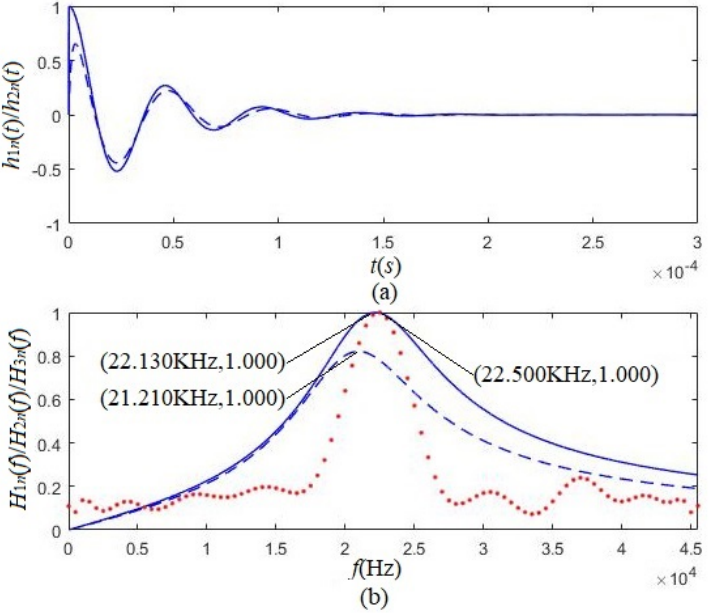
Figure 6. The normalized electric–acoustic impulse responses and corresponding amplitude spectra of the tangentially and radially polarized thin cylindrical piezoelectric transducers. The solid and dashed lines are for the tangentially and radially polarized thin cylindrical transducers, respectively. The dotted line is the experimentally measured amplitude spectrum of tangentially polarized thin cylindrical transducers. Where, h 1 n ( t ) = h 1 ( t ) / h 1max , h 2 n ( t ) = h 2 ( t ) / h 1max , H 1 n ( f ) = H 1 ( f ) / H 1max , H 2 n ( f ) = H 2 ( f ) / H 1max and H 3 n ( f ) = H 3 ( f ) / H 3max . ( a ) Impulse re- sponse, ( b ) Amplitude